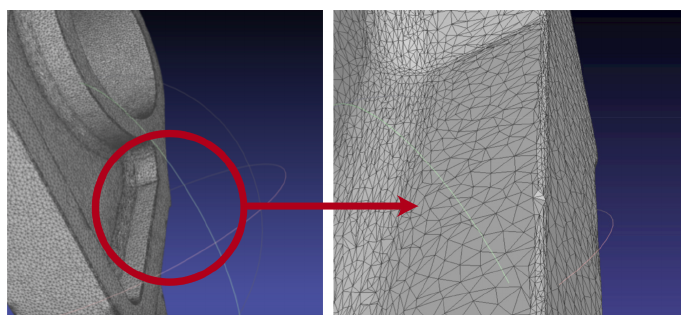
Figure 2. Problematic parts on the